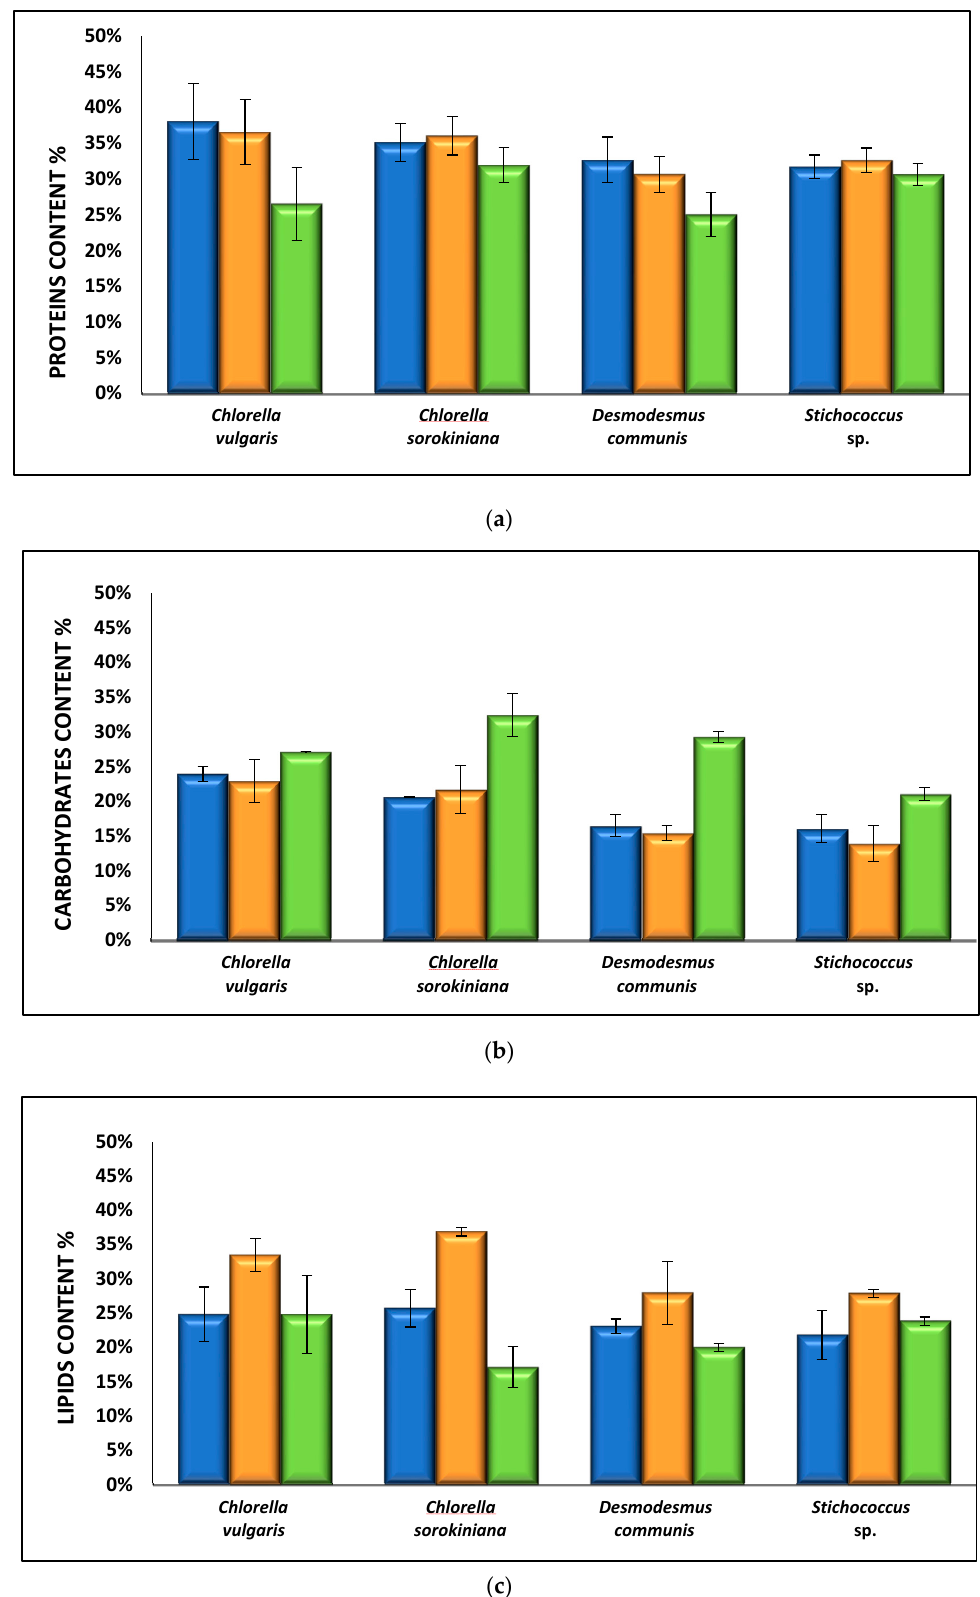
Figure 7. Biochemical composition of the four microalgae species under cultivation in the 3 different media ( a – c ): blue bar: BG-11 NO3 , orange bar: BG-11 NH4 and green bar: 3.7% ADE.